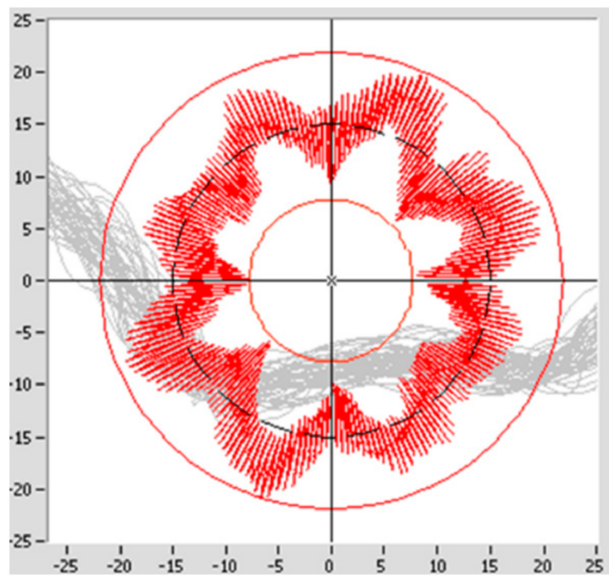
Figure 6. Sample graphs of synchronous